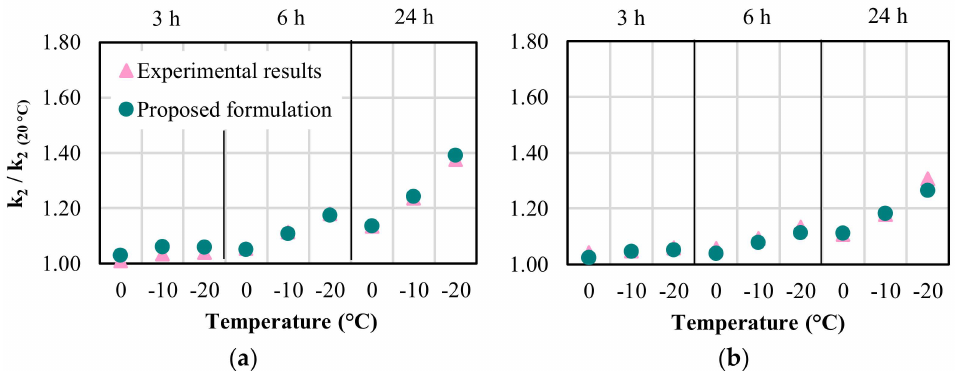
Figure 21. Comparison of experimental amplifications in k 2 with the proposed formulation estima- tions for 0.1 Hz loading frequency at ( a ) 100% and ( b ) 134% shear